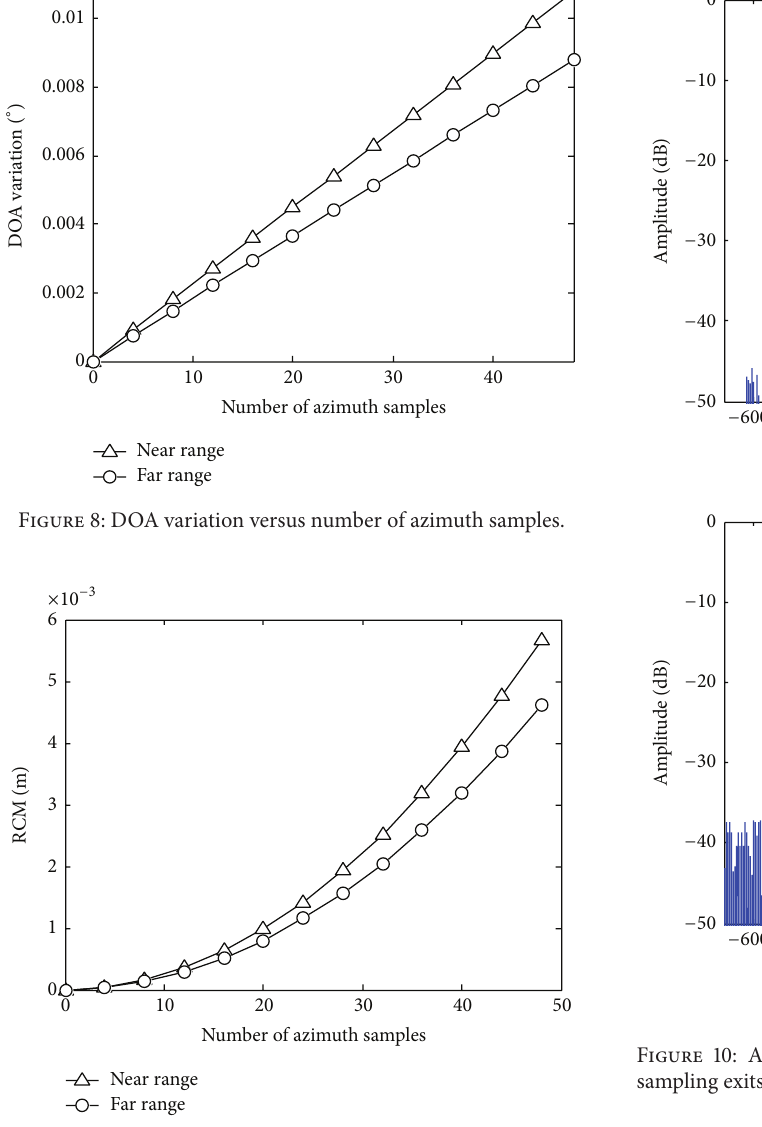
Figure 9: RCM versus number of azimuth samples.